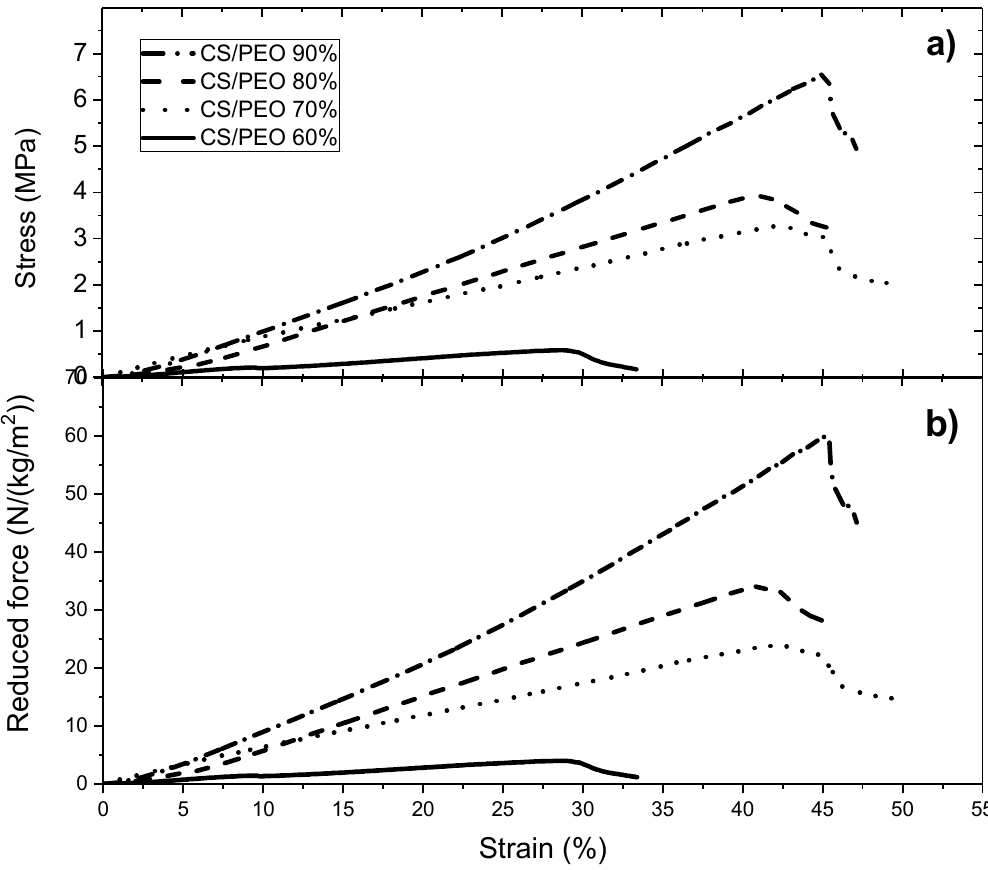
Figure 4. ( a ) Stress under uniaxial traction σ (expressed in MPa) and ( b ) Reduced force (expressed in N/(kg/m 2 )) on films under rehydrated form (wet state) after chitosan neutralization, PEO (under powder form) extraction and drying. PEO M W = 1 × 10 6 . Table 3. Experimental data obtained in uniaxial tensile test on blended films after PEO extraction (PEO 1 × 10 6 ) and drying under wet state.